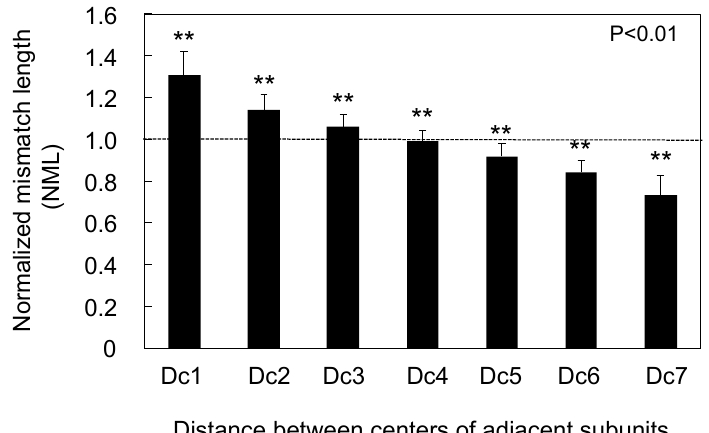
Fig. 1 Normalized mismatch length of each distance between centers of two adjacent subunits The distances between two adjacent subunits located side by side were normalized with the averaged distance among all subunits and defined as normalized mismatch length (NML). The distance showing largest NML is defined as Dc1 and the other distances are numbered from Dc2 to Dc7 in order of the size of the distance. Multiple comparisons were conducted using the Steel-Dwass test, with the level of statistical significance taken as P <0.05. Error bars show standard